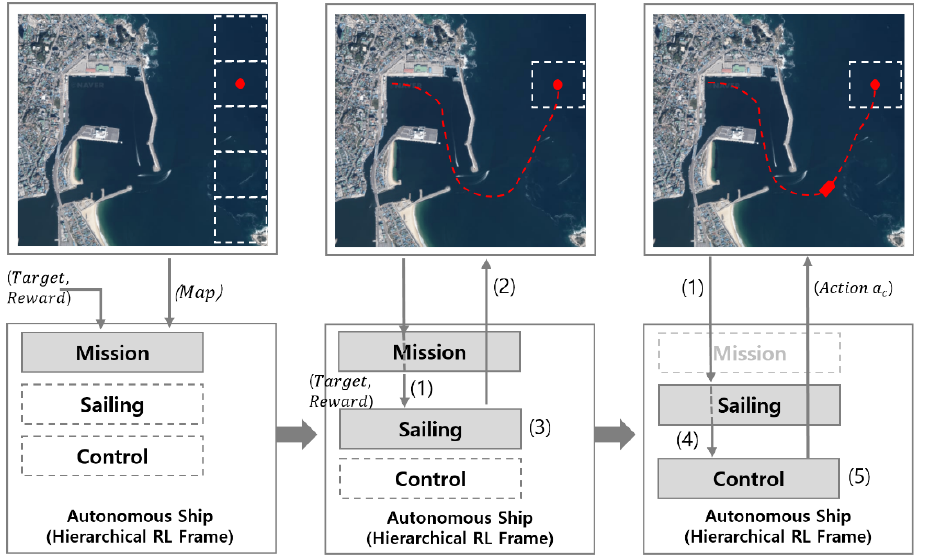
Figure 2. Schematic of the inter-layer supervised learning of hierarchical RL. According to the goals defined by humans, the Mission layer analyzes the space and sets the destination (left). The set goal is transmitted to the Sailing layer, and a delay reward is made according to the result. Sailing learns navigation as in Formula (3) according to Formula (1) observed from the environment, and the route consists of the actions as in Formula (2) (center). After learning, the Sailing layer becomes an observation value of Control , as shown in Formula (4), and Control learns, as shown in Formula (5), and is executed in the environment through the output Action a c . In the Sailing layer, the control is compensated by comparing the learned target value with the environmental change caused by Control ’s